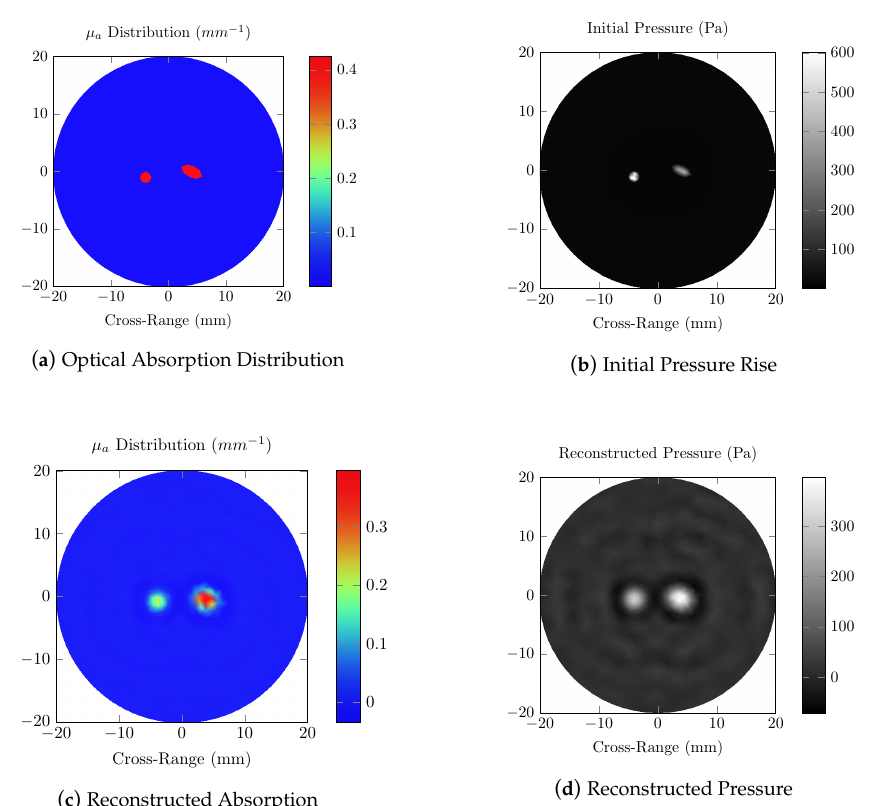
Figure 3. Photoacoustic computed tomography (PACT) simulations using an 800 nm source on the homogeneous phantom with two light absorbing inclusions; ( a ) the true optical absorption distribution; ( b ) the initial pressure rise induced by the photoacoustic effect; ( d ) the reconstructed pressure, calculated using the time-reversal algorithm; and ( c ) the reconstructed absorption, obtained by dividing the reconstructed pressure with the